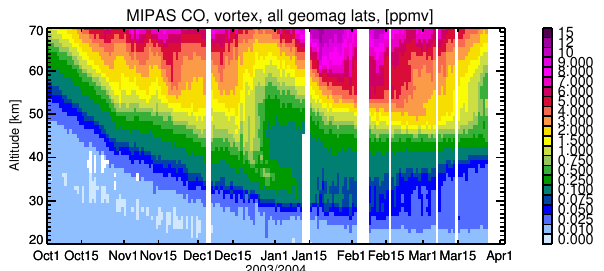
Figure 2. CO as measured by MIPAS in the Northern Hemisphere Fig. 2. CO as measured by MIPAS in the Northern Hemisphere from October 2003 to March 2004 in the latitude bin from 40–90 ◦ North, from October 2003 to March 2004 in the latitude bin from 40 to considering both day and night observations. All geomagnetic latitudes but only within the polar vortex (equivalent latitudes ( Butchart and 90 ◦ N, considering both day and night observations. All geomag- Remsberg , 1986) polewards of 65 ◦ ). Only days with more than 8 data-points were used. netic latitudes but only within the polar vortex (equivalent latitudes (Butchart and Remsberg, 1986) polewards of 65 ◦ ). Only days with more than eight data points were